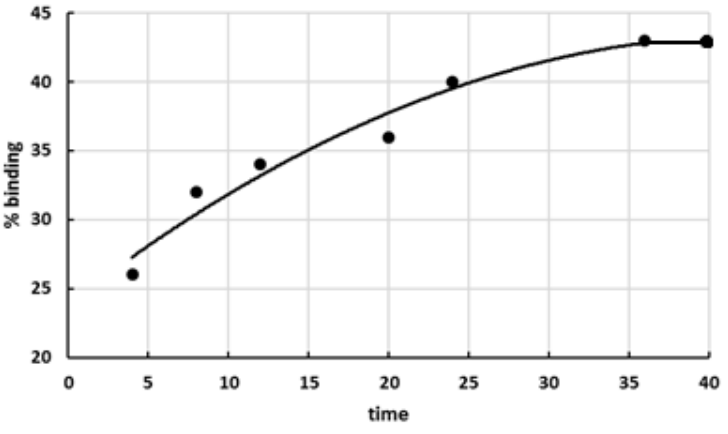
Figure 2. Dependence of the portion of bound lactones of D(+)-glucaric acid on duration of interaction between the polymer carrier and glucarolactones (295 K, phosphate buffer pH 4.75). The ability of lactones to inhibit β -GA depends on their stereoisomeric composition.